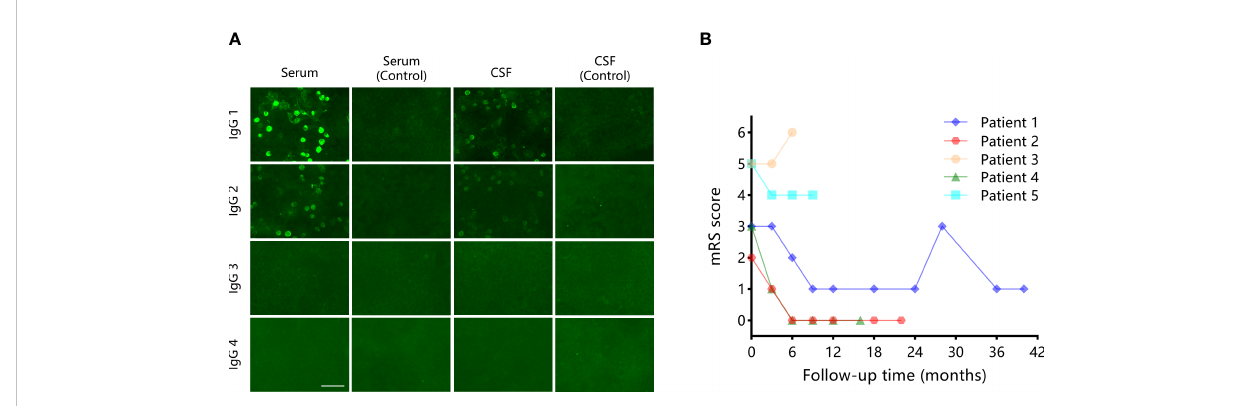
FIGURE 2 A representative mGluR5 antibody testing result and the mRS scores evaluated over the follow-up of the fi ve patients in the current study. (A) mGluR5 IgG subclass results in patient 1. mGluR5 antibodies subclasses were measured on fi xed HEK293 cells using a cell-based assay against the mGluR5 expressed at the cell surface. IgG1 and IgG2 were found in the samples. Negative controls: HEK293 cells expressing empty vector plasmids were incubated with the samples from the same patient. Scale bar: 75 m m. (B) The mRS scores evaluated over the follow-up of fi ve patients in the current